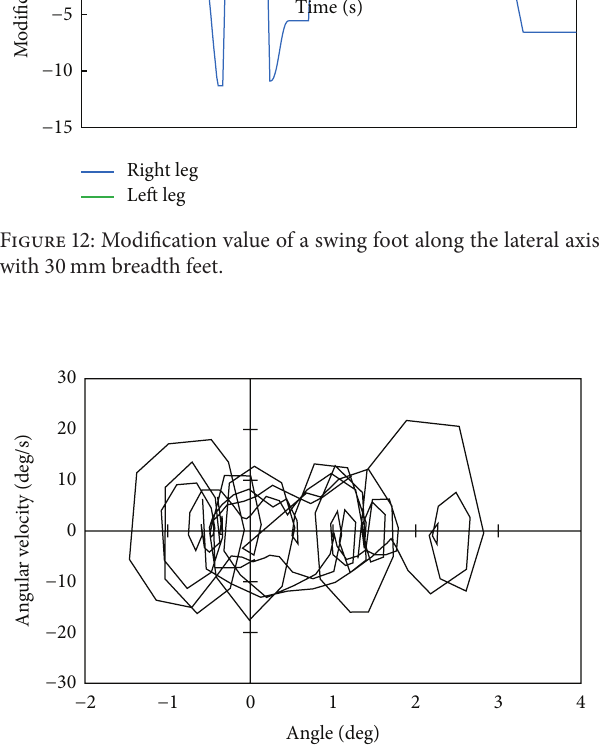
Figure 13: Phase portrait when walking with 30 mm breadth feet.